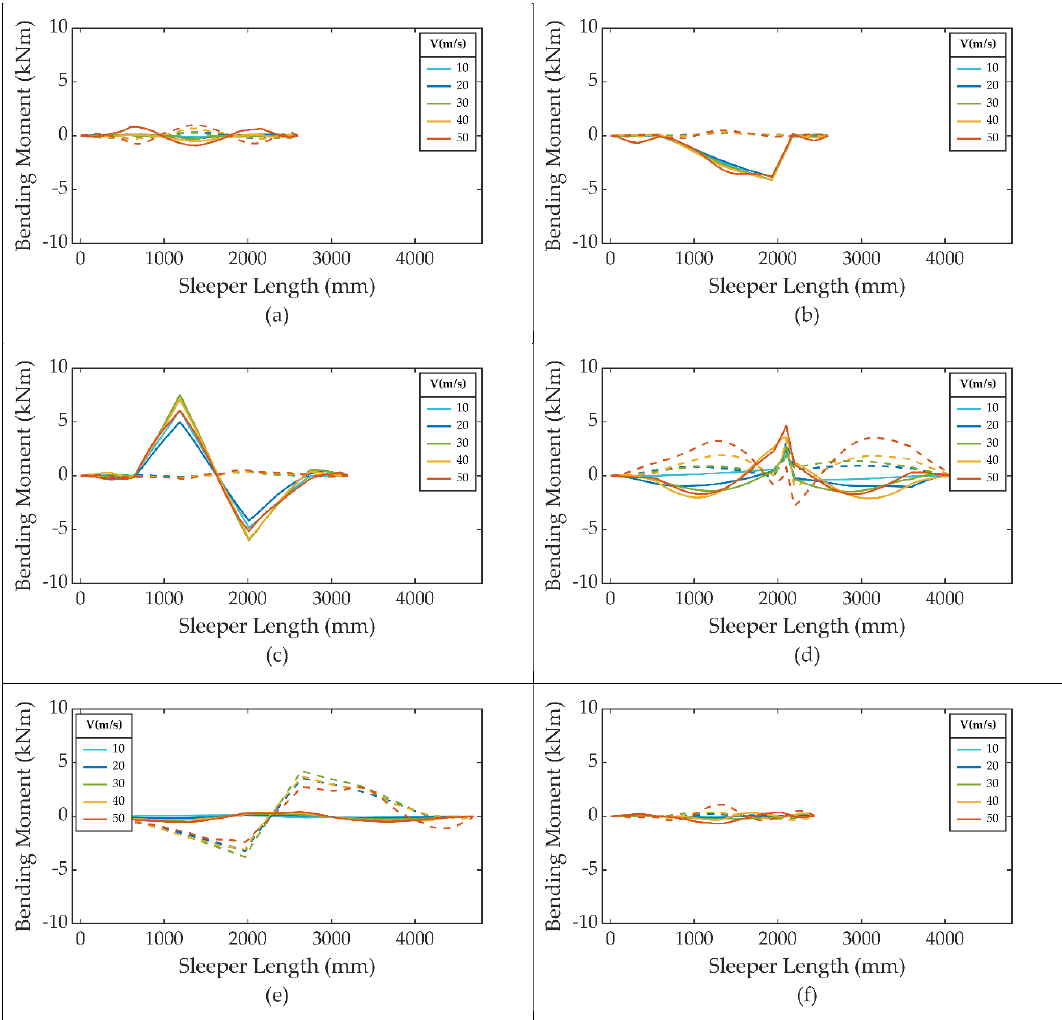
Figure 28. The flexural responses of unsupported bearers when the selected point have maximum and minimum bending moments: ( a ) Bearer at normal track section; ( b ) Bearer under switch blades; ( c ) Bearer at closure panel; ( d ) Bearer under crossing nose; ( e ) The longest bearer; ( f ) The shortest bearer.